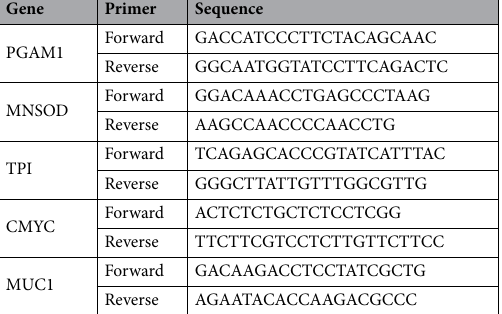
Table 1. Primer sequences for qRT-PCR analysis of target